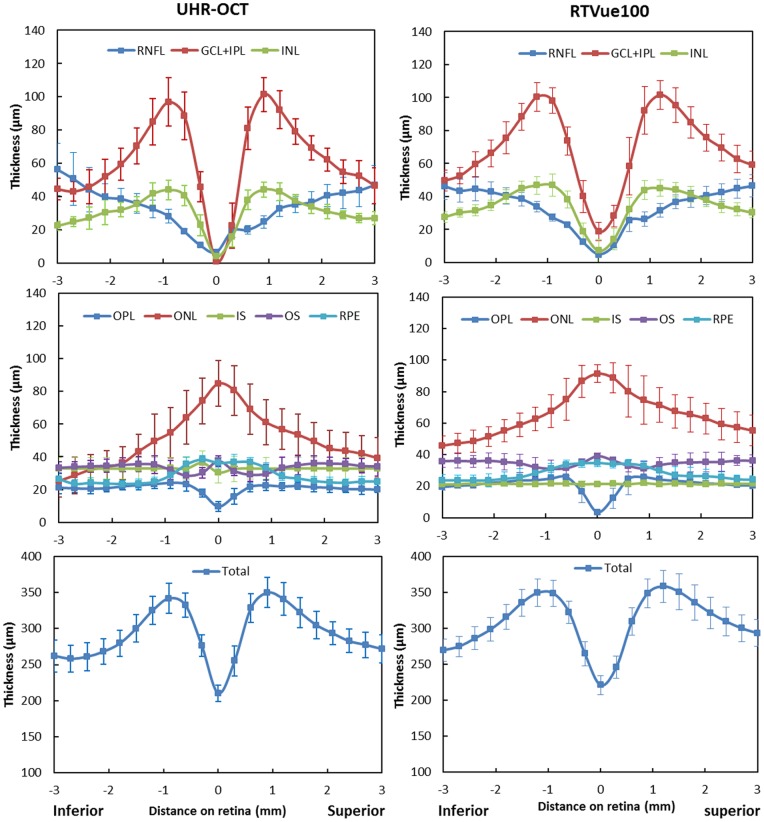
Thickness profiles of eight intra-retinal layers determined from the UHR-OCT and RTVue100 images in the vertical meridian.Thickness profiles of eight intra-retinal layers along the vertical meridian were averaged for 20 normal healthy eyes. Error bars represent standard deviation.